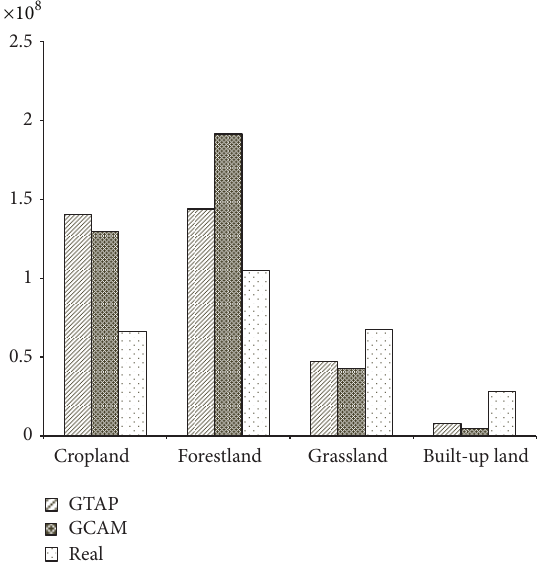
Figure 5: The comparison of land use area in China in 2010 simulated with the calibrated GCAM model, the GTAP model, and the real values (unit: